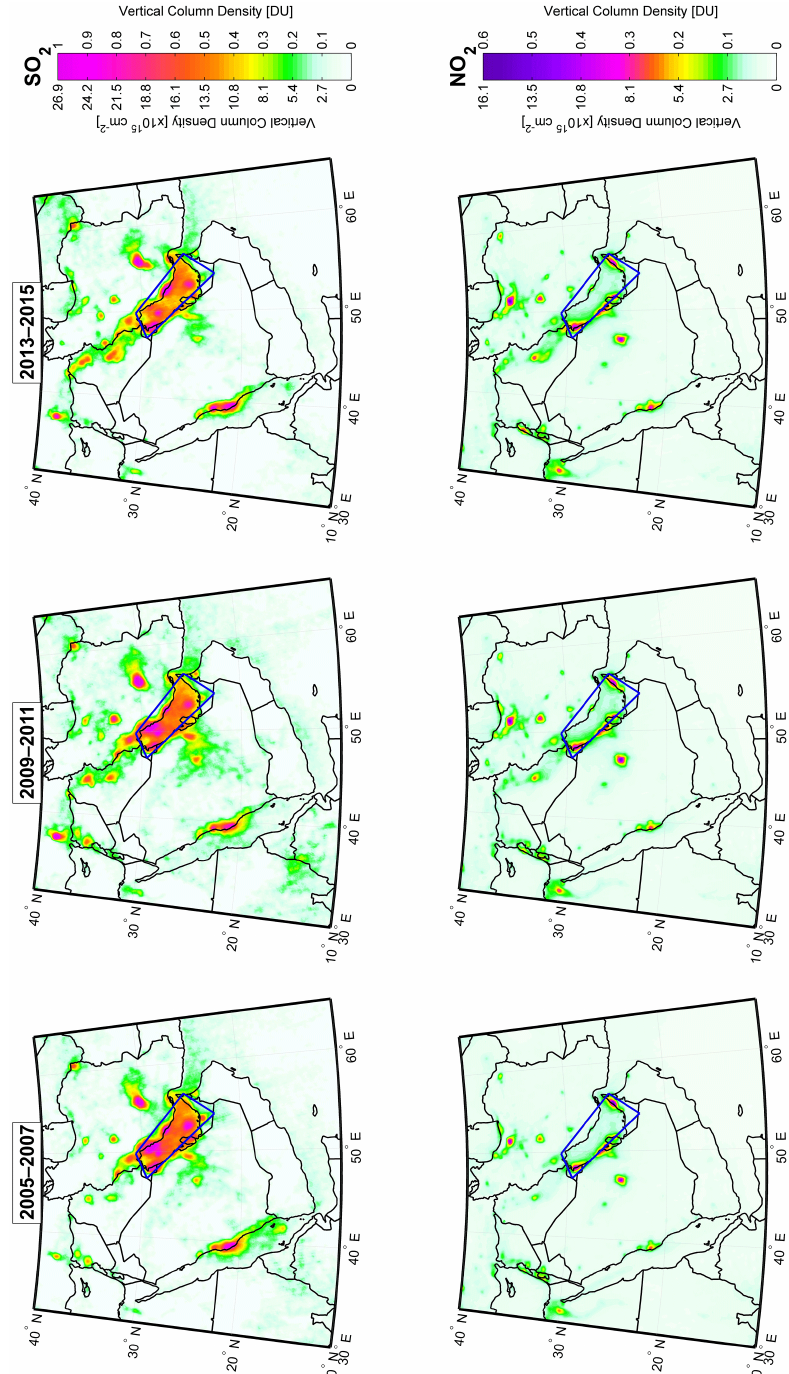
Figure 7. Similar to Fig. 2 but for the Middle East. Blue box outlines Persian Gulf region with high SO 2 and NO 2 levels due to oil and gas